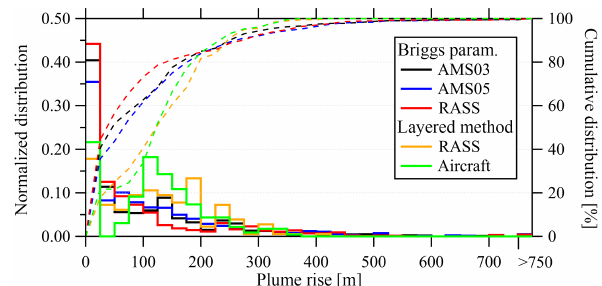
Figure 4. The distribution of calculated plume rise ( (cid:49)h ) using Briggs parameterization (Eqs. 1–6) with input data from the AMS03 and AMS05 towers and the RASS profiler, and the layered method (Eq. 7) with input data from the RASS profiler and the aircraft. Dis- tributions are shown for each hour (using the 46h of box and screen flight times) and for all of 8 SO 2 emitting stacks combined. The right-most histogram bin is the sum of all values of (cid:49)h > 750m. Cumulative distributions shown by dashed